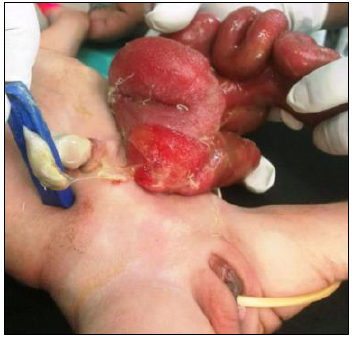
Figure 1: Showing defect lateral to the